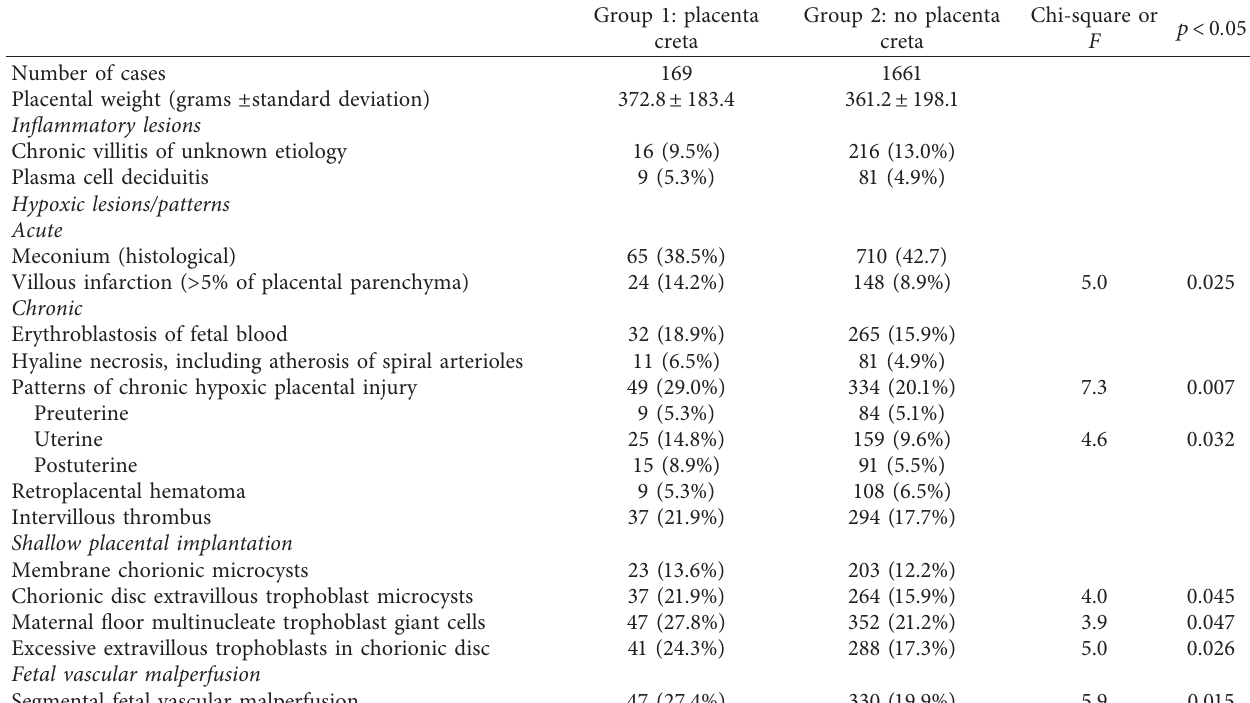
Table 2: Placental